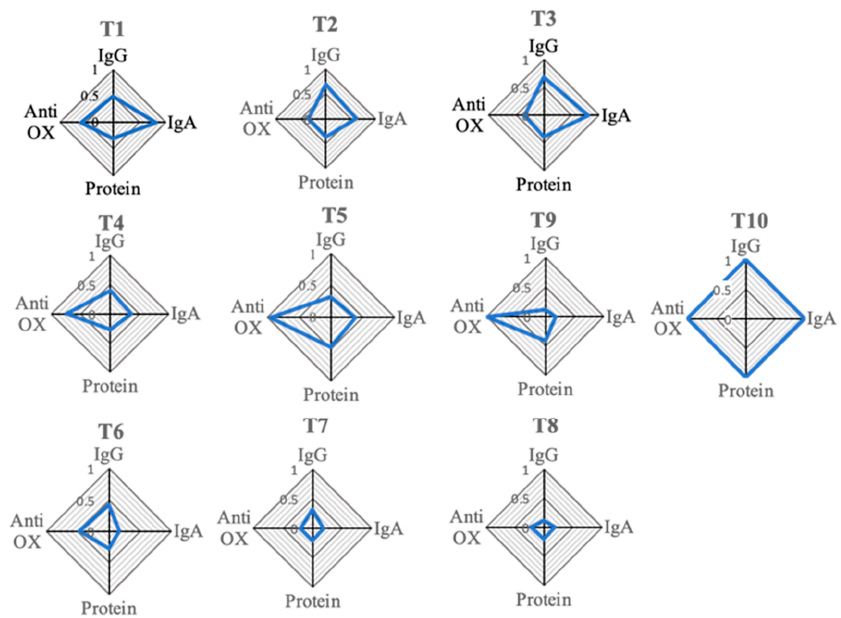
Figure 4. The four datasets of neutralizing antibodies—IgG and sIgA, antioxidant activity, and protein concentration—measured in 10 samples are depicted individually in a radar chart for each individual. The numbers T1–T10 correspond to the sample numbers 1–10 in Figure 3. The data are shown as a ratio of the maximum concentration of each measured item.